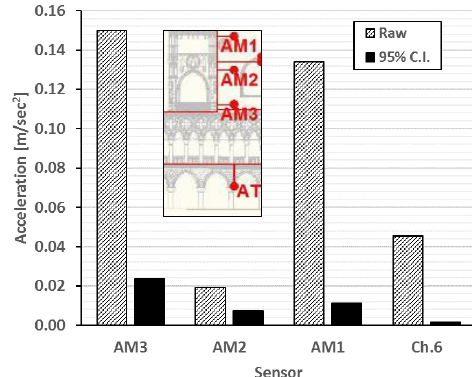
Figure 15. Accelerogram and spectrum by FFT of the signal at 10:06:10 in 25 th June